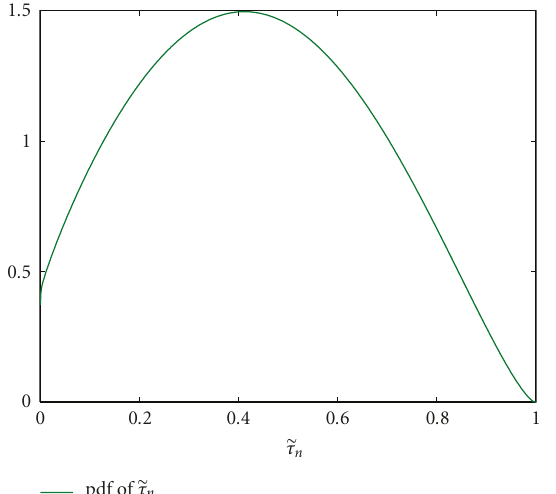
Figure 11: Analytical plot of f (cid:9) τ